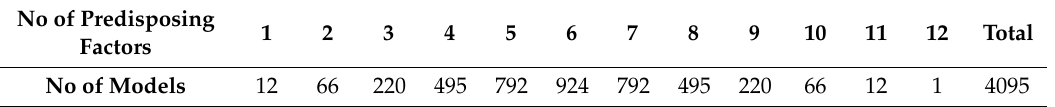
Table 3. Number of landslide susceptibility models obtained with different numbers of predisposing